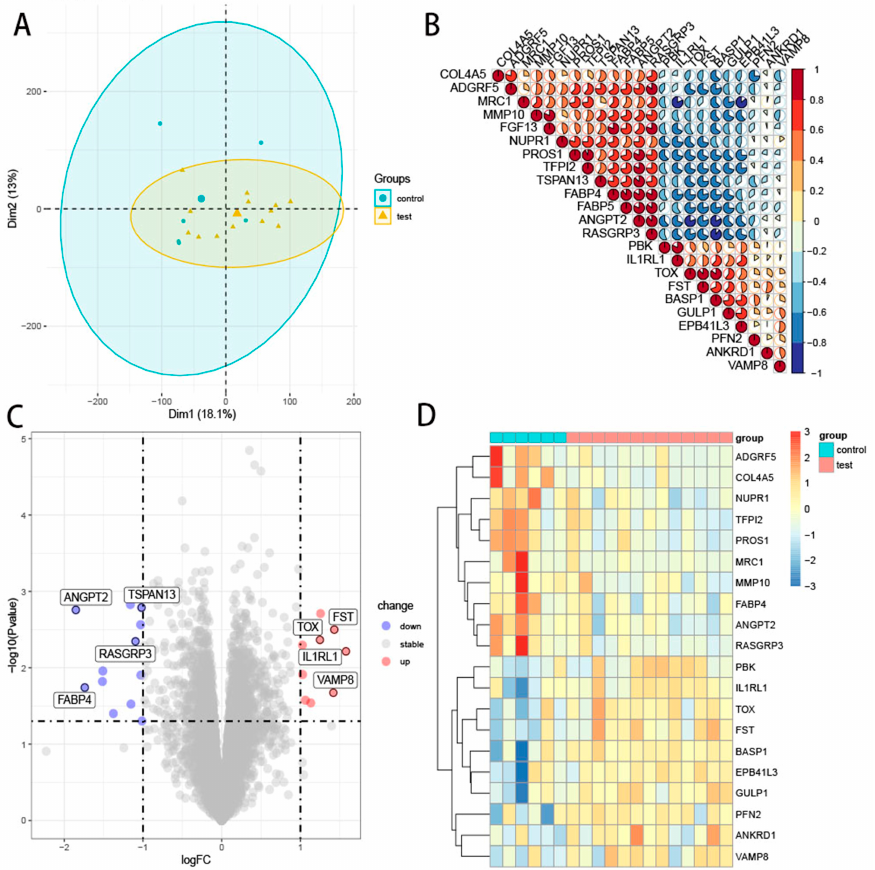
Figure 1. Identification and correlation analysis of significant DEGs in ECA. ( A ) PCA of the two groups. Each point in the graph represents a sample, and the distance between points represents the difference between samples. ( B ) Gene correlation analysis of 23 significant DEGs. Red to blue indicates a strong to weak correlation. ( C ) Volcano plot of the significant DEGs in the two groups. The screening conditions were p < 0.05 and |log 2 FC| > 1. Red represents high expression and green represents low expression. Grey shows no differential expression. ( D ) Heat map of significant DEGs in each sample. Red to blue indicates a strong to weak correlation. (DEGs, differentially expressed genes; ECA, early coronary atherosclerosis; PCA, principal component